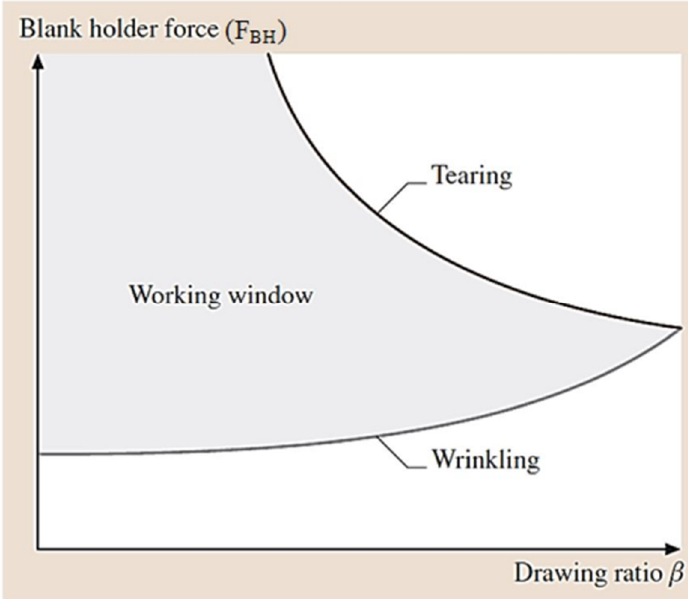
Figure 7. The working domain in the deep drawing process [9].